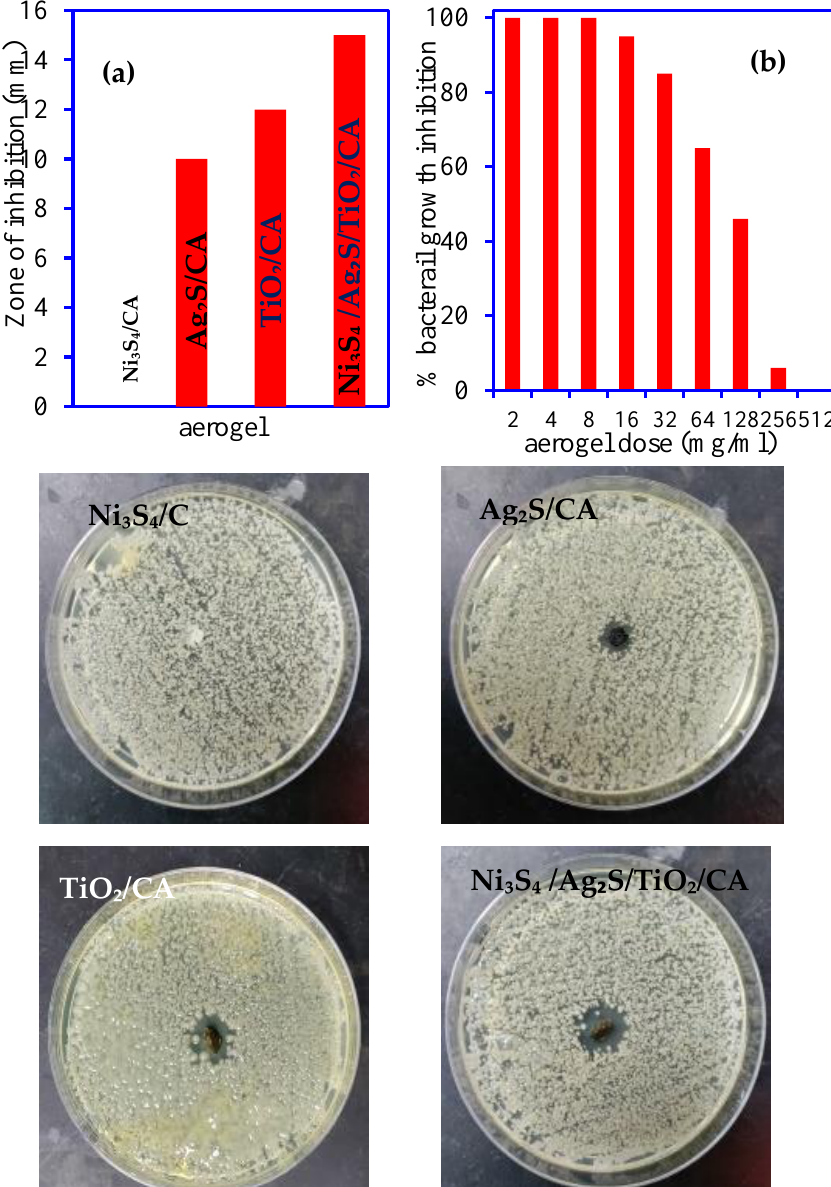
Figure 14. ( a ) Zone inhibition pattern at 100 µg aerogel concentration (zone inhibition in Petri plate) ( b ) effect of Ni 3 S 4 /Ag 2 S/TiO 2 /CA doses on percent bacterial growth inhibition.